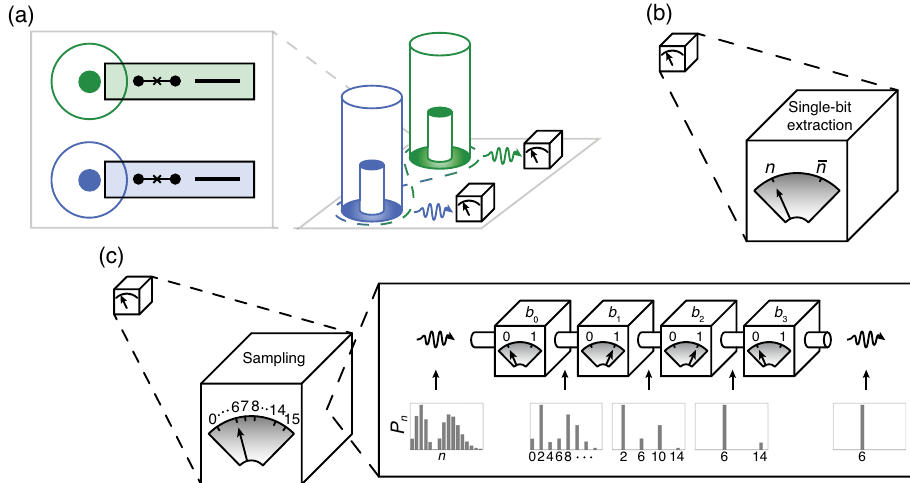
FIG. 2. QND measurements of cavity photon number. (a) Depiction of two 3D λ = 4 coaxial cavities dispersively coupled to individual ancillary modules (outlined in black), each consisting of an ancilla qubit and a readout resonator. From the point of view of the measurement, the ancillary modules serve as reconfigurable black boxes used to detect the photon number in each cavity. The dotted trace serves to illustrate that the state of the two cavities can generally be entangled. (b) Single-bit extraction. In this scheme, on a given run of the experiment, each ancilla is excited conditioned on a predetermined photon number n in its respective cavity. (c) Sampling. Here, instead of having a binary output, each detection module serves as a photon number resolving detector. Sequential QND measurements of the operators associated with the first four bits of each photon number ’ s binary decomposition resolve up to 15 photons per mode. For a general state of the cavity, each measurement projects the state into the eigenspace of the outcome, ultimately projecting out a single Fock state with its corresponding probability. In the schematic, a sequence sampling the 6 photon component ( j 6 i ¼ j 0110 i ) from a displaced Fock state is shown. The state is first probabilistically measured to be in the b 0 ¼ 0 (even parity) subspace, thus projecting out only even photon numbers. The next measurement further projects this state into the b 1 ¼ 1 subspace, and so on, until the measurement converges on a single photon